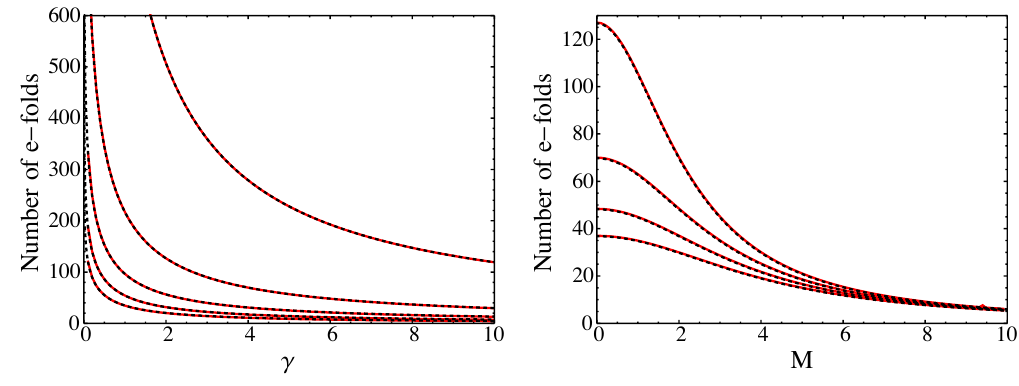
Figure 1 . The total number of e -folds of in(cid:13)ation using the full numerical evolution of the system (red) and using eq. (2.27) (black-dotted). Left: the number of e -folds is plotted as a function of (cid:13) for M = 0